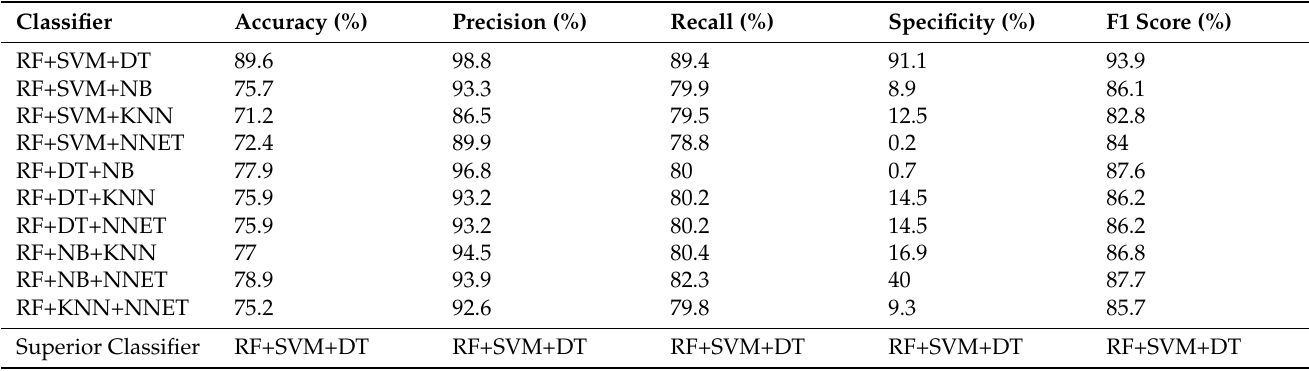
Table 6. Performance comparison of the ensemble classifiers approaches on the bagging im- puted